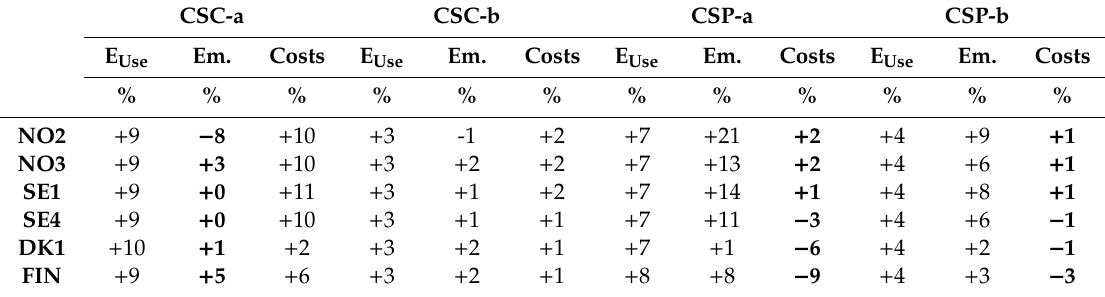
Table 5. Cost and CO 2eq. emission savings relative to the respective reference cases for all six bidding zones (E USe —energy use; Em.—emissions; CSC—control strategy carbon; CSP—control strategy price). CSC-a CSC-b CSP-a CSP-b E Use Em. Costs E Use Em. Costs E Use Em. Costs Em.